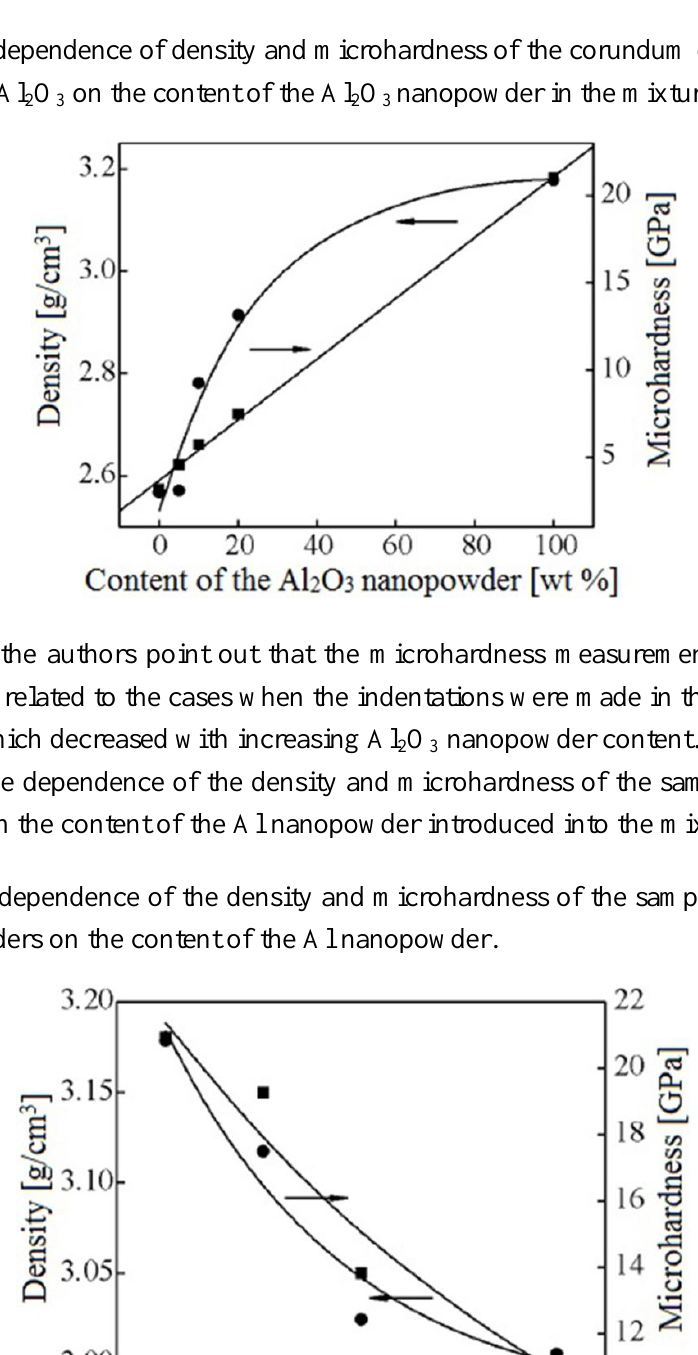
Figure 33. The dependence of density and microhardness of the corundum ceramics sintered